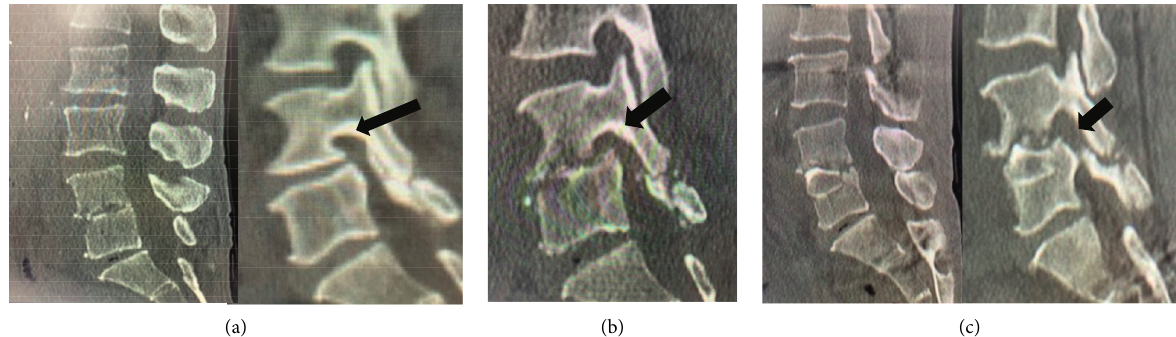
Figure 3: A 77-year-old male had severe back pain and could not sit for a long time due to pyogenic spondylodiscitis at the L4/L5 level. He underwent surgery with FED; however, not only did the postoperative pain scale scores remain unchanged, but also left thigh pain and quadriceps muscle weakness also appeared. He underwent anterior spinal fusion with an iliac strut autograft 13 days after FED. After the revision surgery, low back pain and neurological disorder improved. (a) Preoperative sagittal CTscan images showing destructive changes, including narrowing of disc height and destruction of the endplate at the L4/L5 level, although the foraminal sagittal view did not show foraminal stenosis (arrow). (b) Foraminal sagittal CTscan view after FED showing the progress of vertebral destruction and stenosis of the foramen (arrow). (c) Sagittal CT scan images showing regained foraminal space (arrow) after open surgery with anterior strut